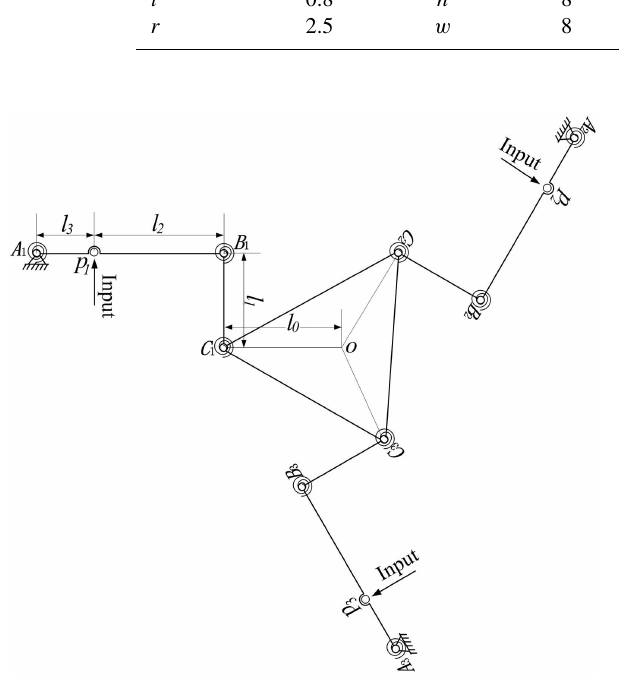
Figure 9. The PRB model of the designed compliant parallel stage.